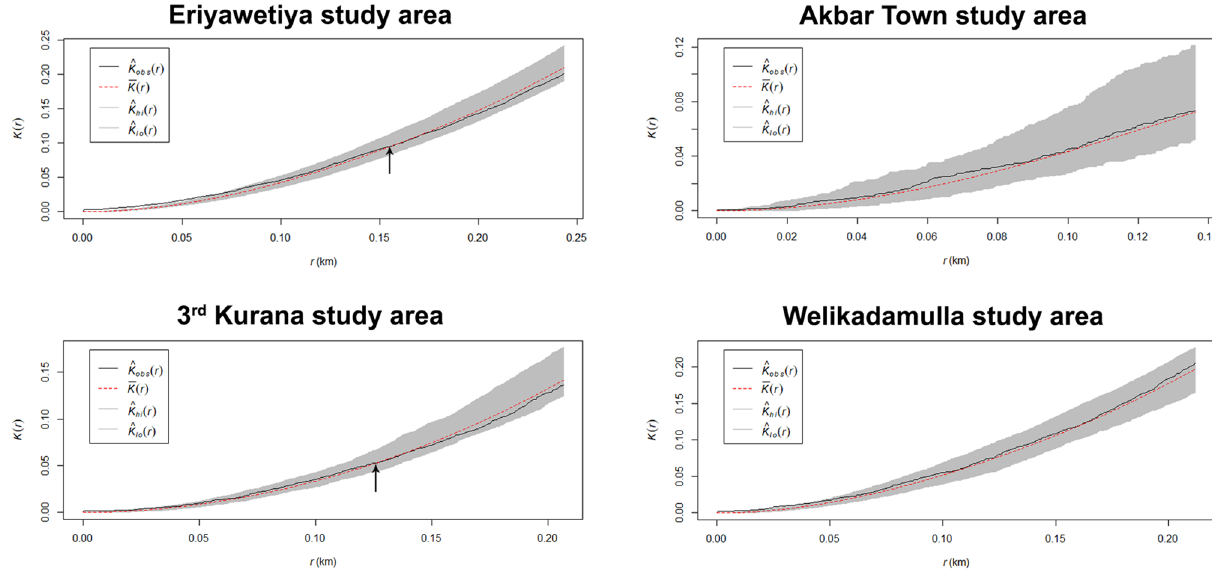
Figure 3. Observed Ripley’s K-functions and simulated envelopes for Poisson point process models in the study areas. r —The vector of values of the argument r at which the function K has been estimated; of K ( r ) ; obs —Observed values of the summary function for the dengue patient location data pattern; lo —Lower envelope of simulations; hi —Higher envelope of